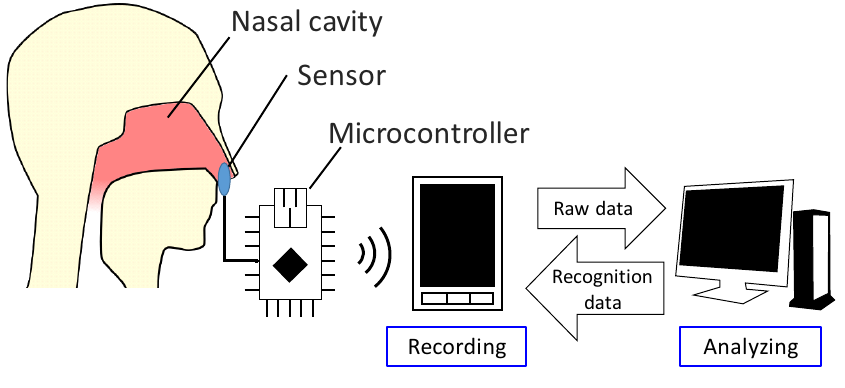
Figure 1. Hardware